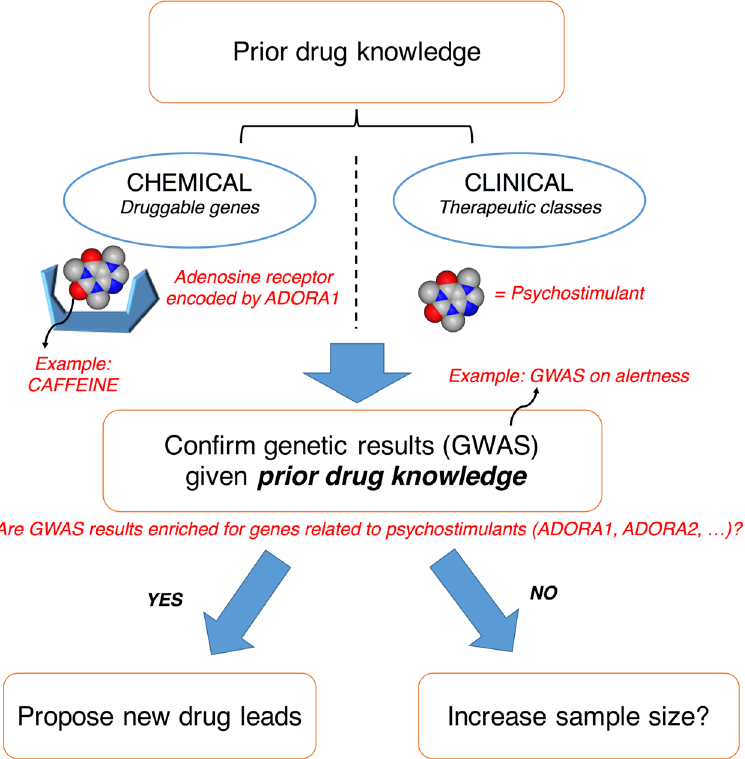
Figure 1. Using drug knowledge to corroborate genetic results. Drug knowledge, encompassing therapeutic classes and druggable genes ( e.g ., caffeine is a psychostimulant targeting adenosine receptors), may be used to confirm the ability of a GWAS to find known drugs for a given trait ( e.g ., alertness). Novel targets and potential drugs could then be found in genetic